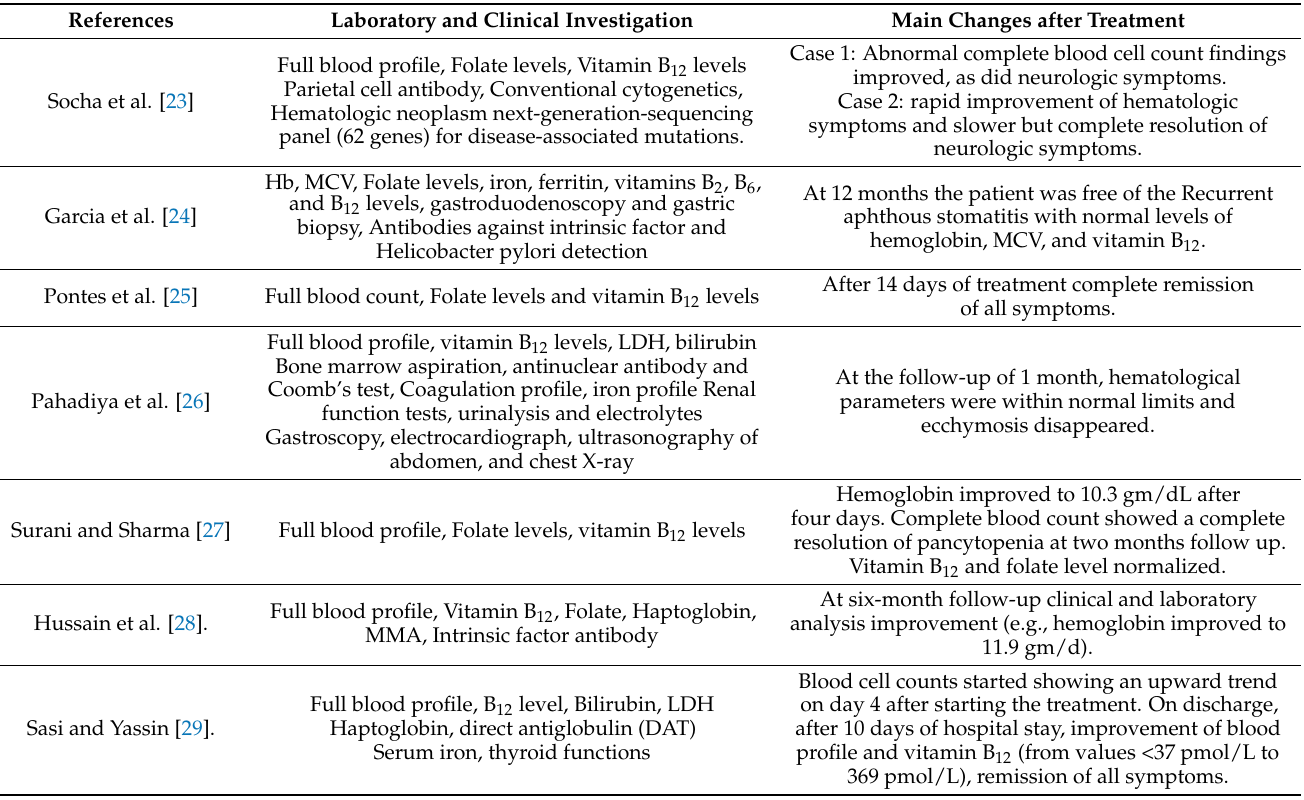
Table 1. Laboratory and clinical investigations of the reported cases in the section on vitamin B 12 deficiency and anemia, with main changes after treatment.